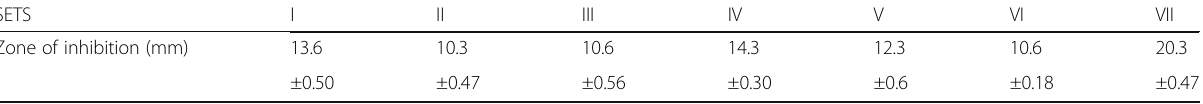
± − Standard deviation values derived from the mean of data from three independent